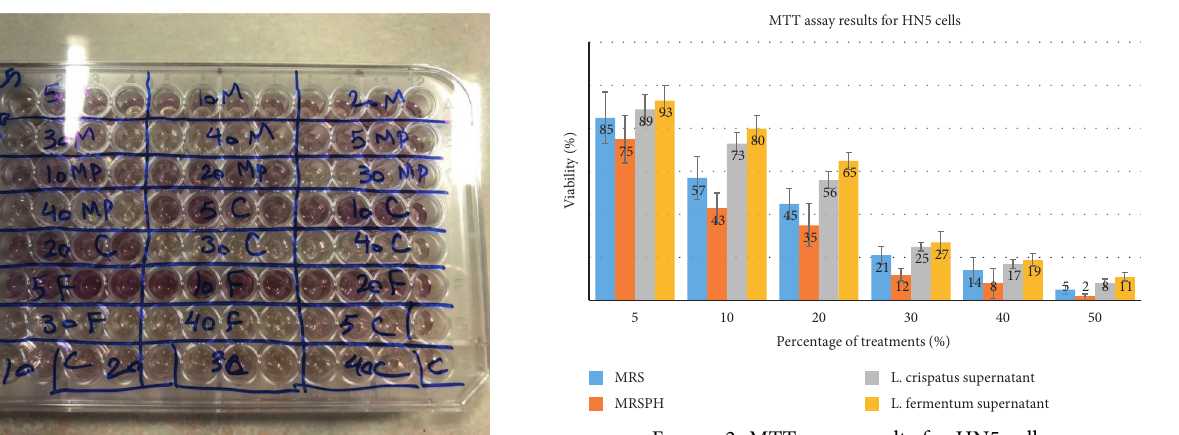
Figure 1: The results of the MTTassay for different concentrations of L. crispatus (C), L. fermentum (F), MRS (M), and MRSPH (Mp) on HN5 cells. Table 1: IC50 of cancer cells in different environments. Concentration